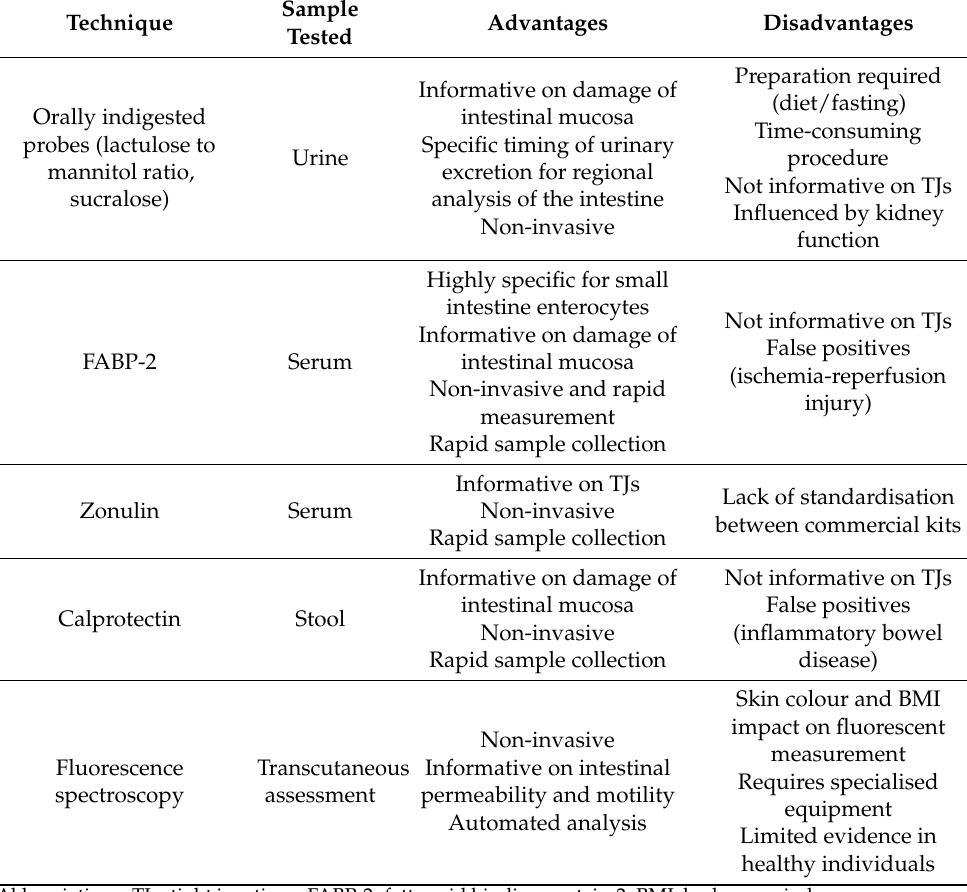
Table 1. Techniques for in vivo measurement of gut